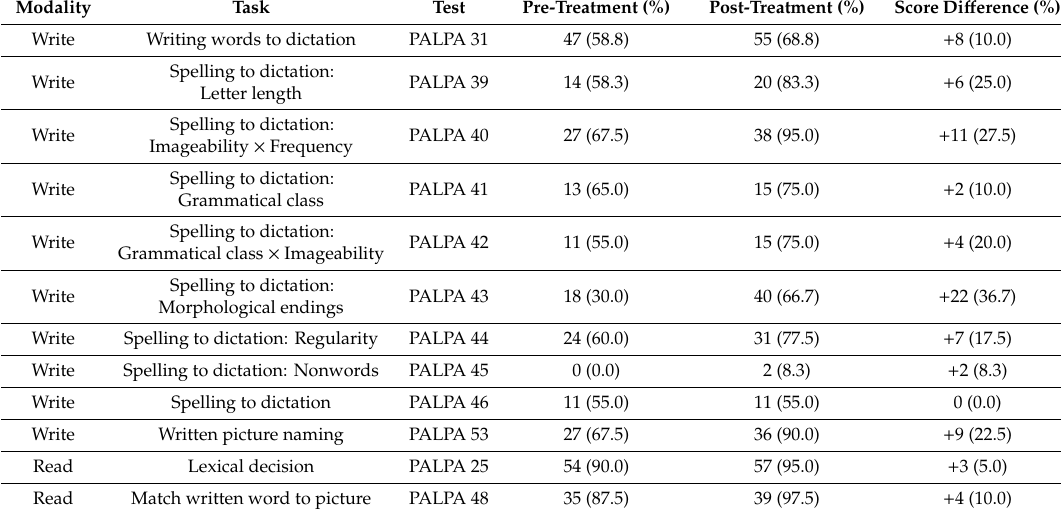
Table 2. Results of Psycholinguistics Assessment of Language Processing in Aphasia